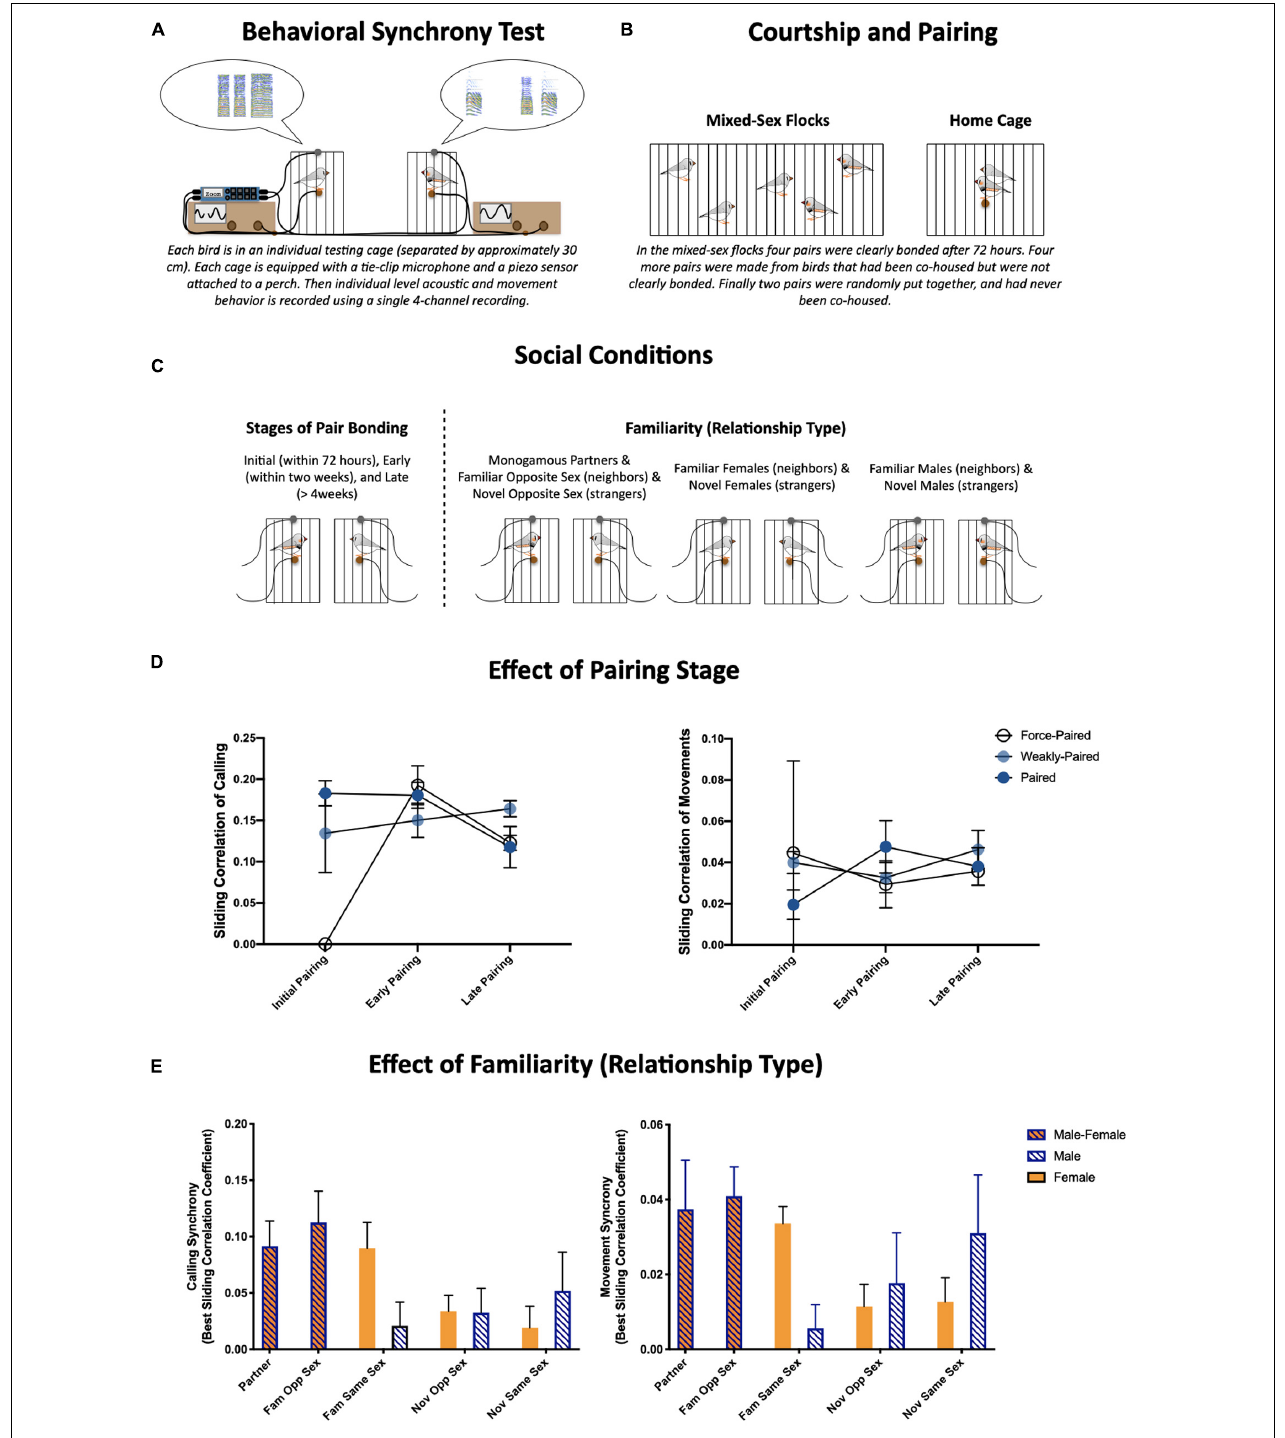
FIGURE 1 | (A) Schematic of the behavioral synchrony paradigm used to quantify behavior during social reunions (greets). The finer, moment-to-moment details of these interactions were quantified from single four-channel recordings of acoustic data from tie-clip microphones and movement data from piezo sensors attached to each perch. (B) Illustration of paradigm used to set up pairs. (C) We quantified behavioral synchrony during social reunions over the course of pair bonding [initial pairing (4–72 hours), early pairing (within the first two weeks), and late pairing ( > 4 weeks) (Left)], and across different social relationships (Monogamous partners, familiar same- and opposite-sex dyads as well as novel same- and opposite-sex dyads). (D) Effects of pairing stage and prior experience on behavioral synchrony (temporal synchrony based on sliding correlation coefficients) of calls (left) and movements (right) (Prior et al., 2020). (E) Effects of social relationship on behavioral synchrony (temporal synchrony based on sliding correlation coefficients) of calls (left) and movements (right) (Prior et al., 2019).